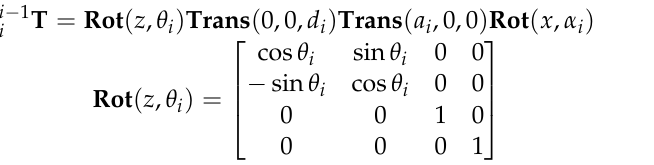
In Equation (9), θ i is the angle for which x i -1 spins around z i to become x i ; d i is the distance between x i -1 and x i along z i ; a i is the distance between z i and z i +1 along x i , and α i is the angle for which z i spins around x i to become z i +1 . Rot ( z , θ i ) represents the rotation matrix of the z -axis; θ i , d i , α i , and a i are shown in Figure 12b. 𝐓 (cid:3036)(cid:3036)(cid:2879)(cid:2869) is shown in Equation (10), where s represents the sine function and c represents the cosine function.